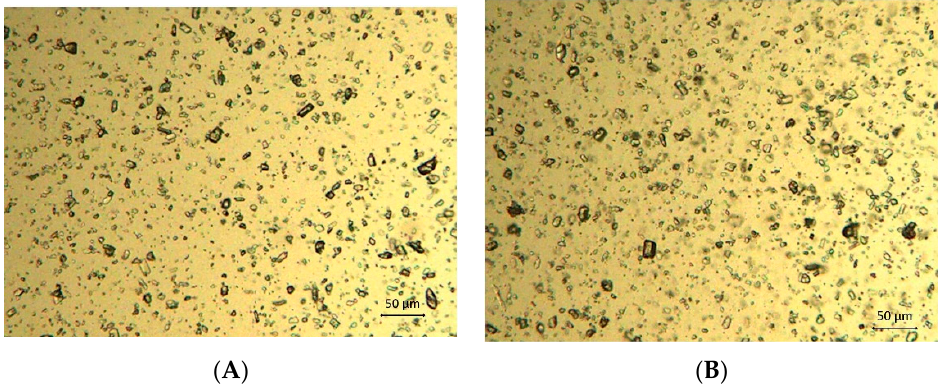
Figure 1. The optical images of F1 ( A ) and F3 hydrogels ( B ) (original magnification 100×).